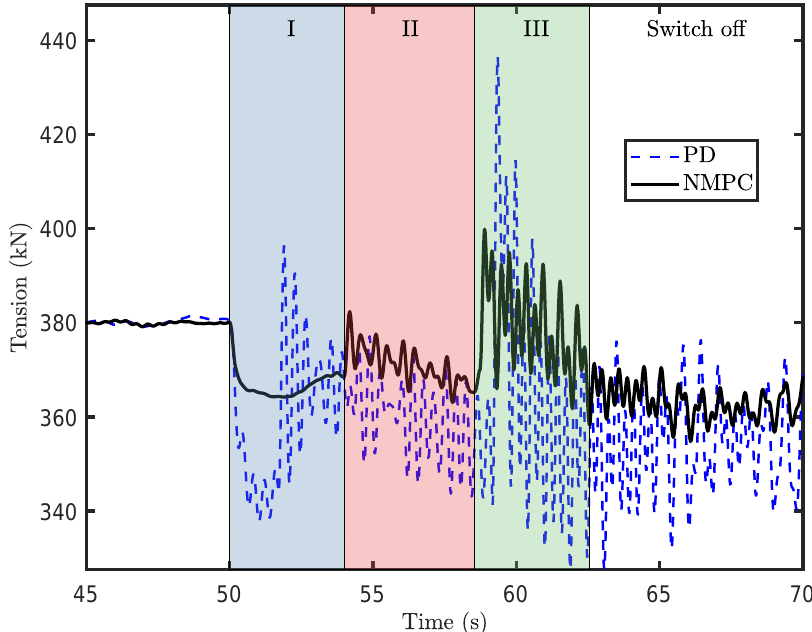
Figure 13. Comparison of the time-domain simulation results of the tension on the lift wire, γ = 0.5, mean wind speed 8 m/s, TI = 0.174.